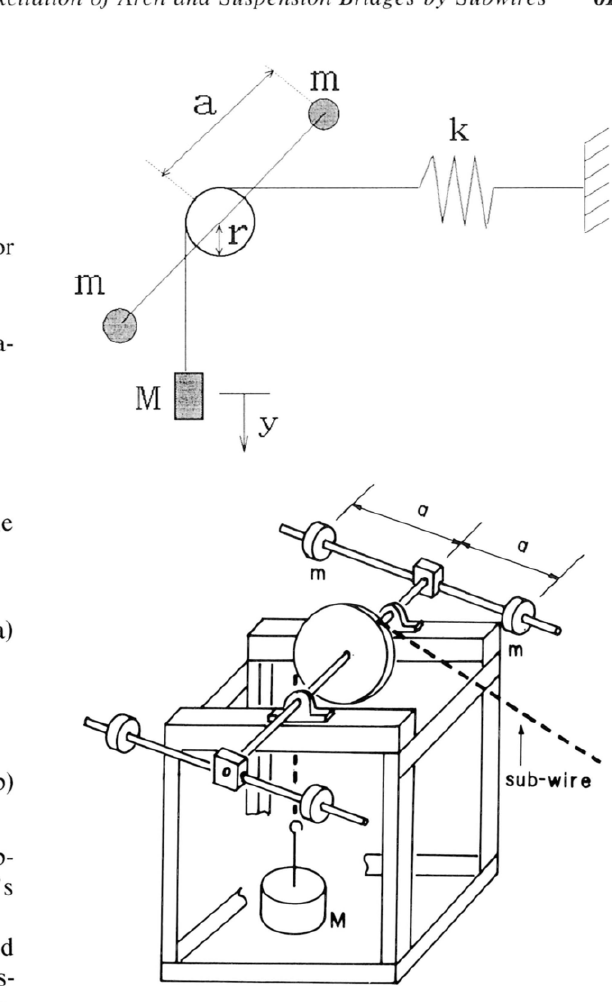
FIGURE 3 (a) Schematic model of the resonance force generator; (b) the resonance force